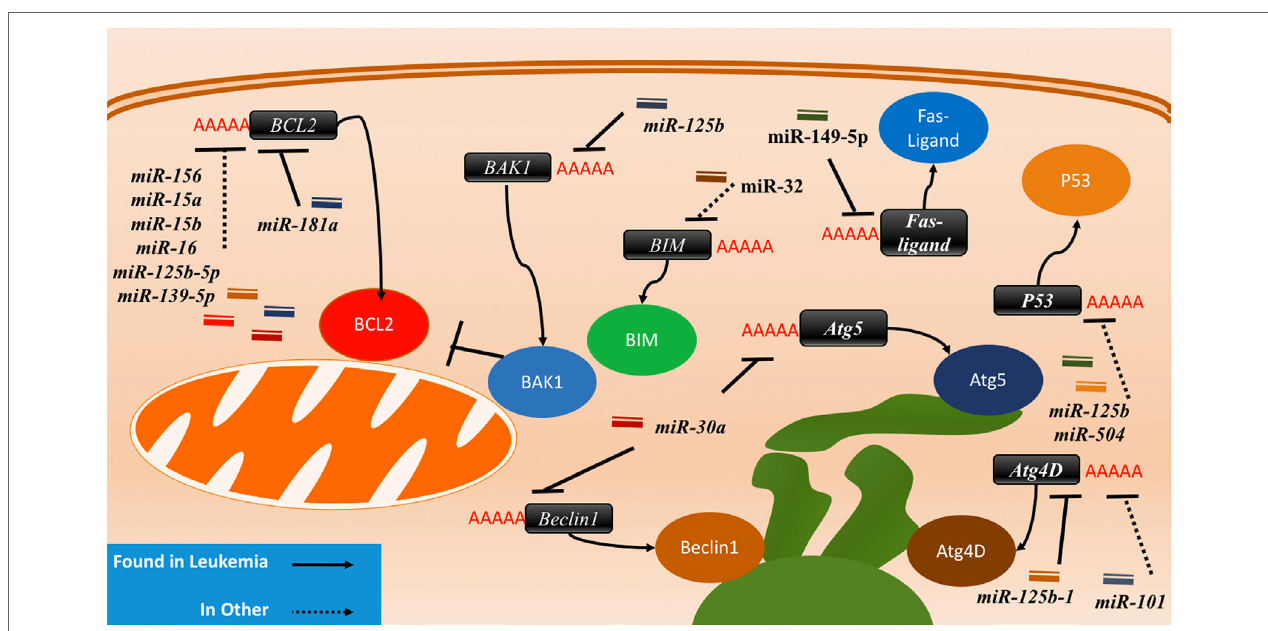
FigURe 4 | The interactions between microRNAs (miRNAs) and cell death-related proteins in drug resistant cells. Within the apoptosis cell death mechanism, proteins part of the intrinsic or extrinsic pathway can respond to miRNAs to inhibit apoptosis or reduce their regulatory signaling of apoptosis. BCL2, an anti- apoptosis gene, will gain signaling when the associated miRNAs such as miR-156, miR-15a/b, miR-16, miR-125b-5p, and miR-139-5p are lost in the drug resistant cell. The gain of BAK1 miRNA targeting through miR-125b or the gain of BIM targeting through miR-32 will lead to the same effect as well. The Fas-ligand can also be suppressed by miR-149-5p thus ending extrinsic apoptosis signaling. P53 suppression through miR-125b and miR-504 will prevent apoptosis as well. Dysregulating autophagy through increased targeting may increase drug resistance through the binding of miR-125b and miR-101 on Atg4D. miR-30a is known to inversely correlate with Beclin1 and Atg5 in leukemia cell lines, but less is known about the outcome of this